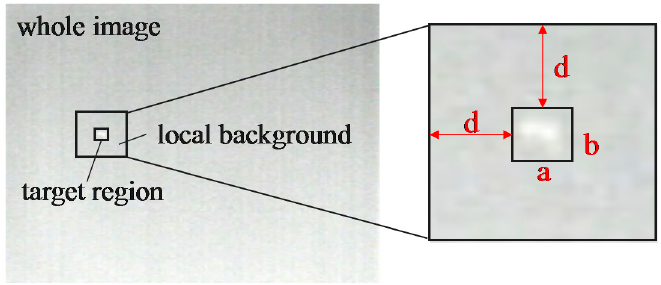
Figure 5. Local region of a small target in an infrared image.